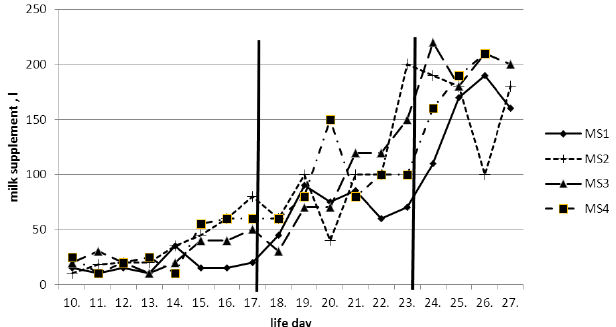
Figure 1. The periodicity of total milk supplement consump- tion from the 10th day of life until weaning, in different groups (Lday − 1